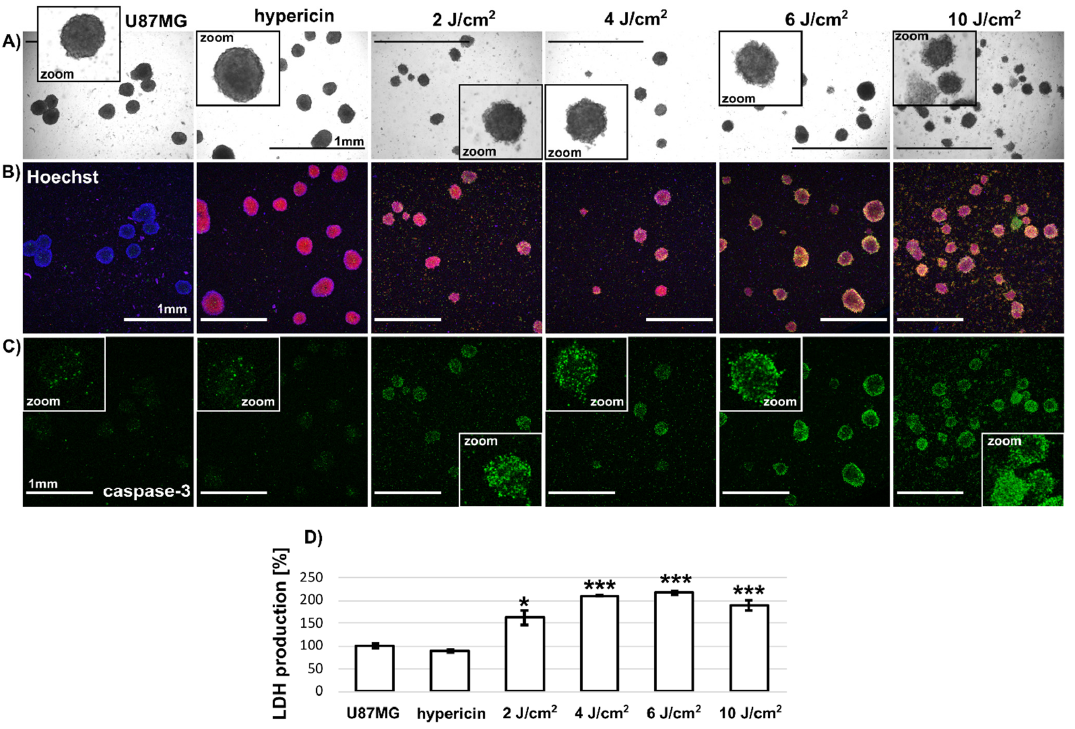
Figure 6. ( A ) Brightfield and fluorescence ( B ) overlap images of Hoechst (blue), hypericin (red) and ( C ) NucView ® 488 caspase-3 (green). The insets show magnifications to better identify the morphology of the spheroids. U87MG cells spontaneously formed in spheroids were detected in the absence and presence of 500 nM hypericin and 24 h after irradiation with different light doses (2–10 J/cm 2 ). Scale bar represents 1 mm. ( D ) LDH production in U87MG cells without and with 500 nM hypericin and irradiation (2–10 J/cm 2 ). The level of significant differences was analysed by one-way method ANOVA, * p < 0.05 and *** p < 0.001. The experiments were performed in triplicate. Table 2. Reduction in size of U87MG spheroids observed after hypericin mediated PDT. The values represent the average size values of all spheroids detected (n = 15).